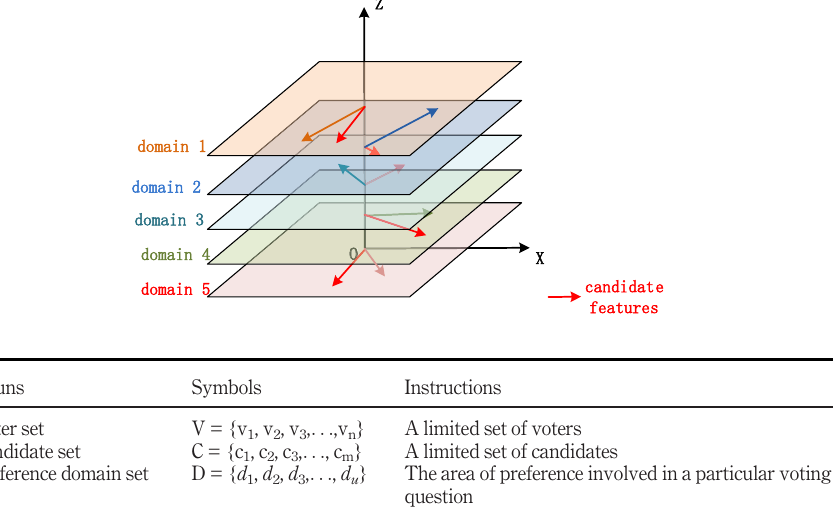
Table V. Basic nouns and